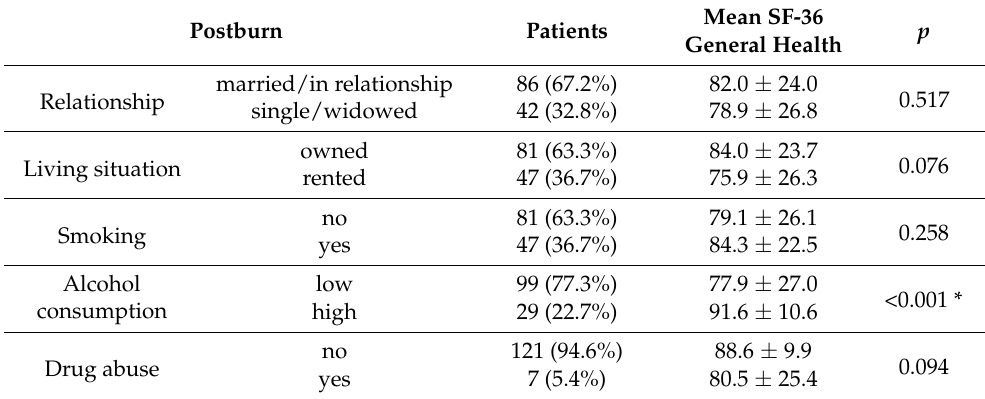
Table 4. SF-36 general health scores relative to living situation, relationship, smoking, alcohol consumption, and drug abuse postburn. * =